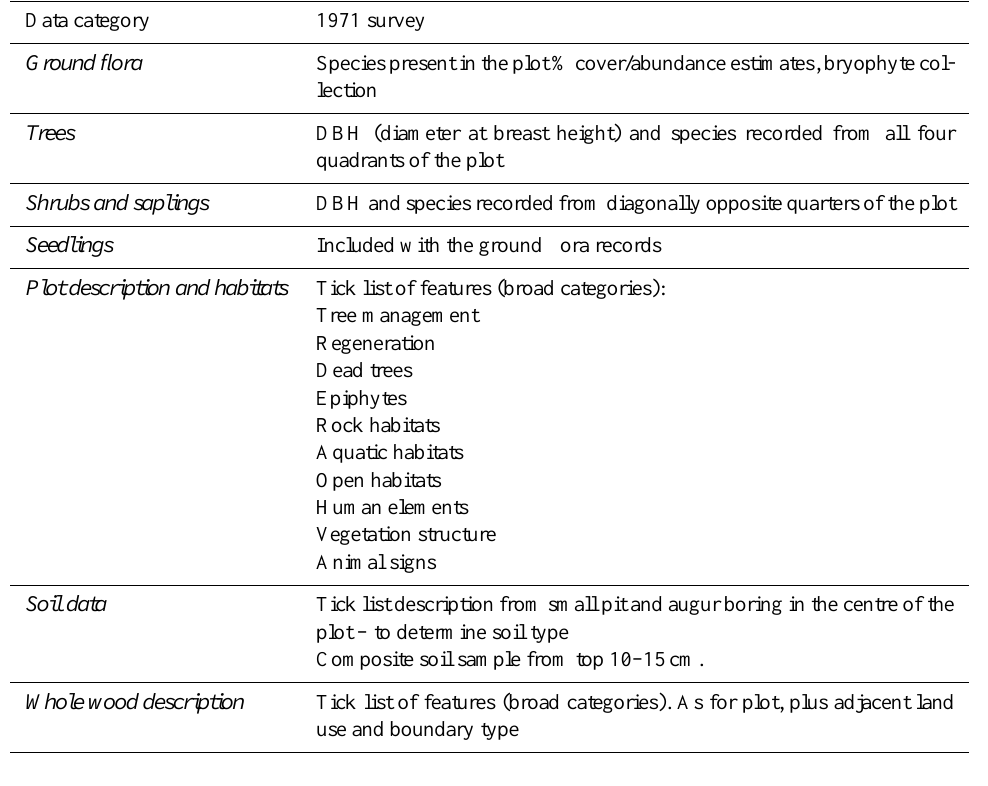
Table 2. Summary of data collected.